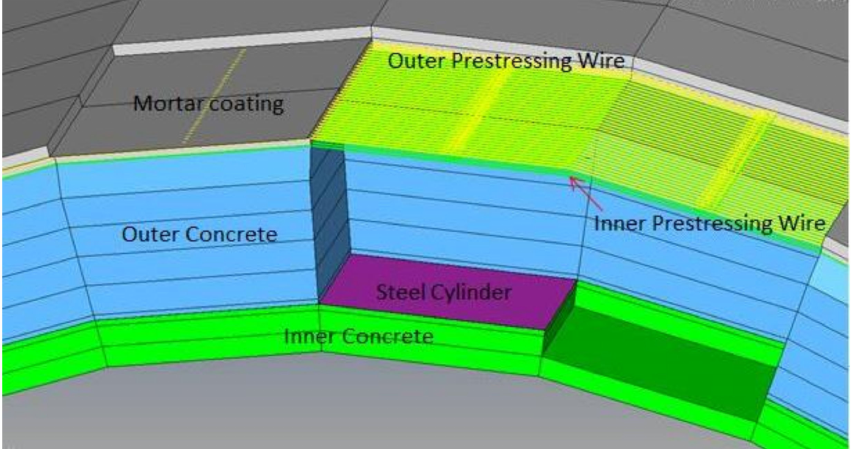
Figure 1. ECP components in ECP finite element model.